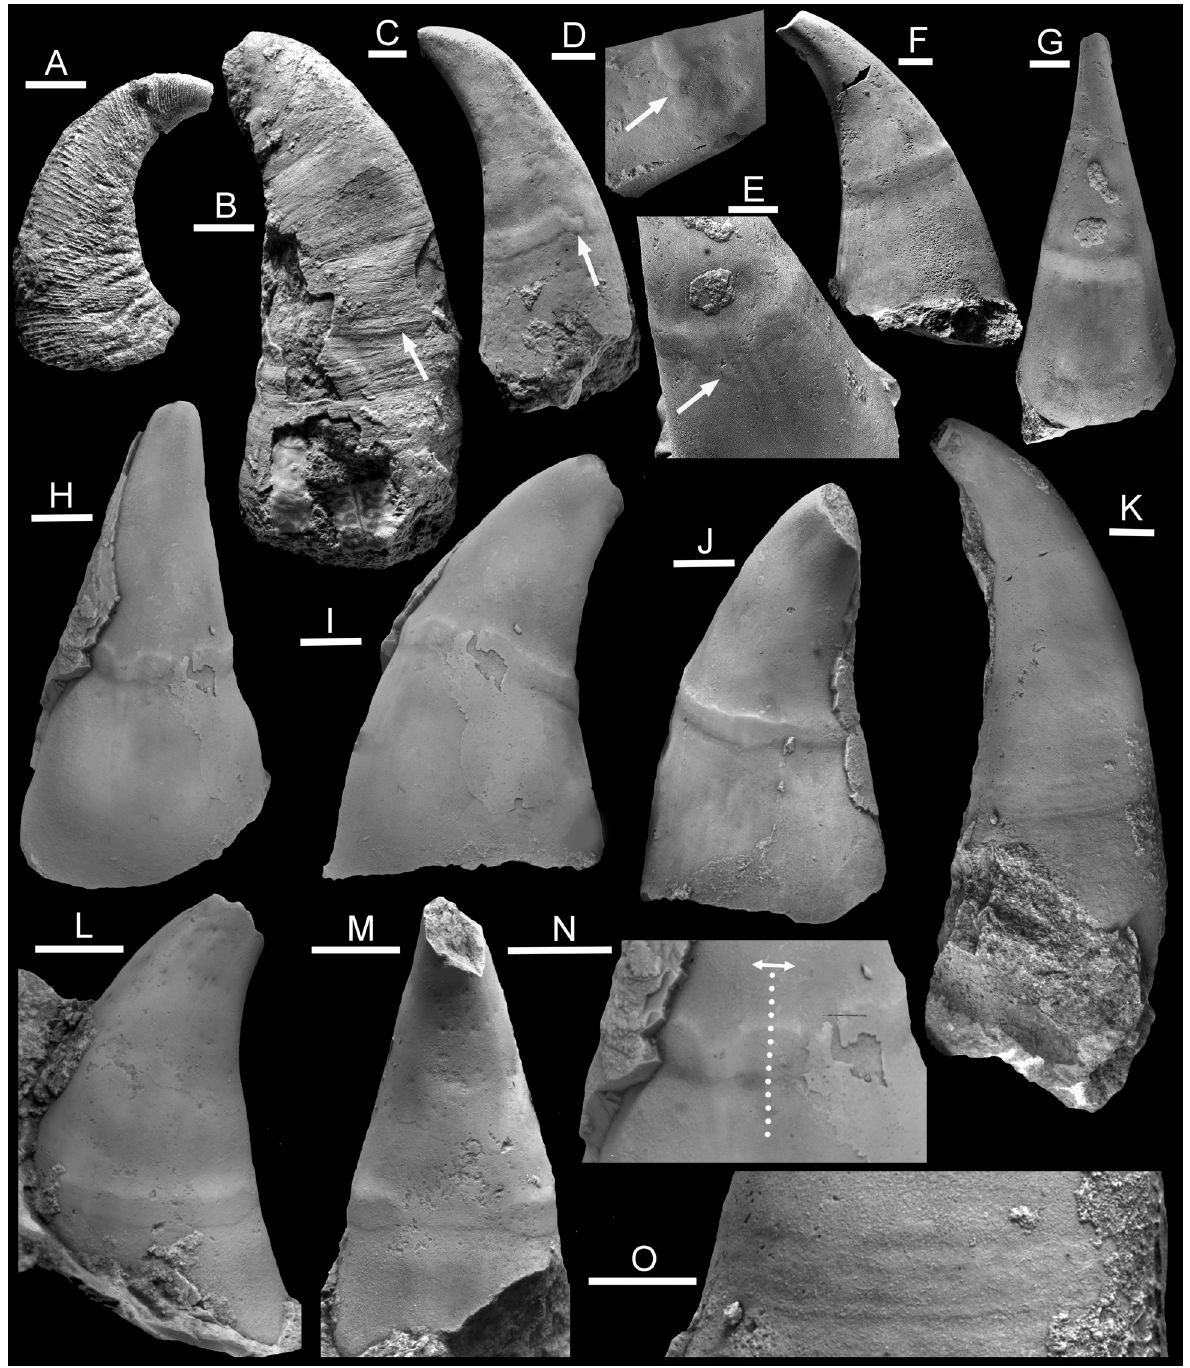
Fig. 3. Pollicina Koken in Holzapfel, 1895. Ordovician, Darriwilian, Kunda Stage. A , B , Pollicina corniculum (Eichwald, 1860), Pulkowa (=Pulkovo), St Petersburg, Russia: A, CNIGRM 15702 (200/10903), lateral view with deep scratches resulting from preparation on right side; B, CNIGRM 15703 (201/10903), lateral view showing dislocation of growth lines, arrow. C – N , Pollicina crassitesta Koken, 1897, internal moulds. C – D , CNIGRM 15600 (394/10903), lateral view with small scars arrowed, Laaksberg (=Lasnamägi), Tallinn. E – G , CNIGRM 15597 (392/10903), Laaksberg (=Lasnamägi), Tallinn: E, sub­apical surface with median ridge–furrow complex arrowed; F, lateral view; G, supra­apical surface. H – J , N , ELM g1:2323, Tallinn: H, oblique view of supra­apical surface (see detail in N); I, lateral view; J, oblique view of sub­apical surface; N, detail of muscle band on supra­apical surface with median plane of symmetry indicated. L , M , ELM G1:2919, Tallinn: L, lateral view; M, sub­apical view. K , O , Pollicina sp., ELM G1:353, internal mould, Estonia, precise locality unknown: K, lateral view; O, detail of muscle band. Scale bars = 5 mm (E–G), otherwise 4